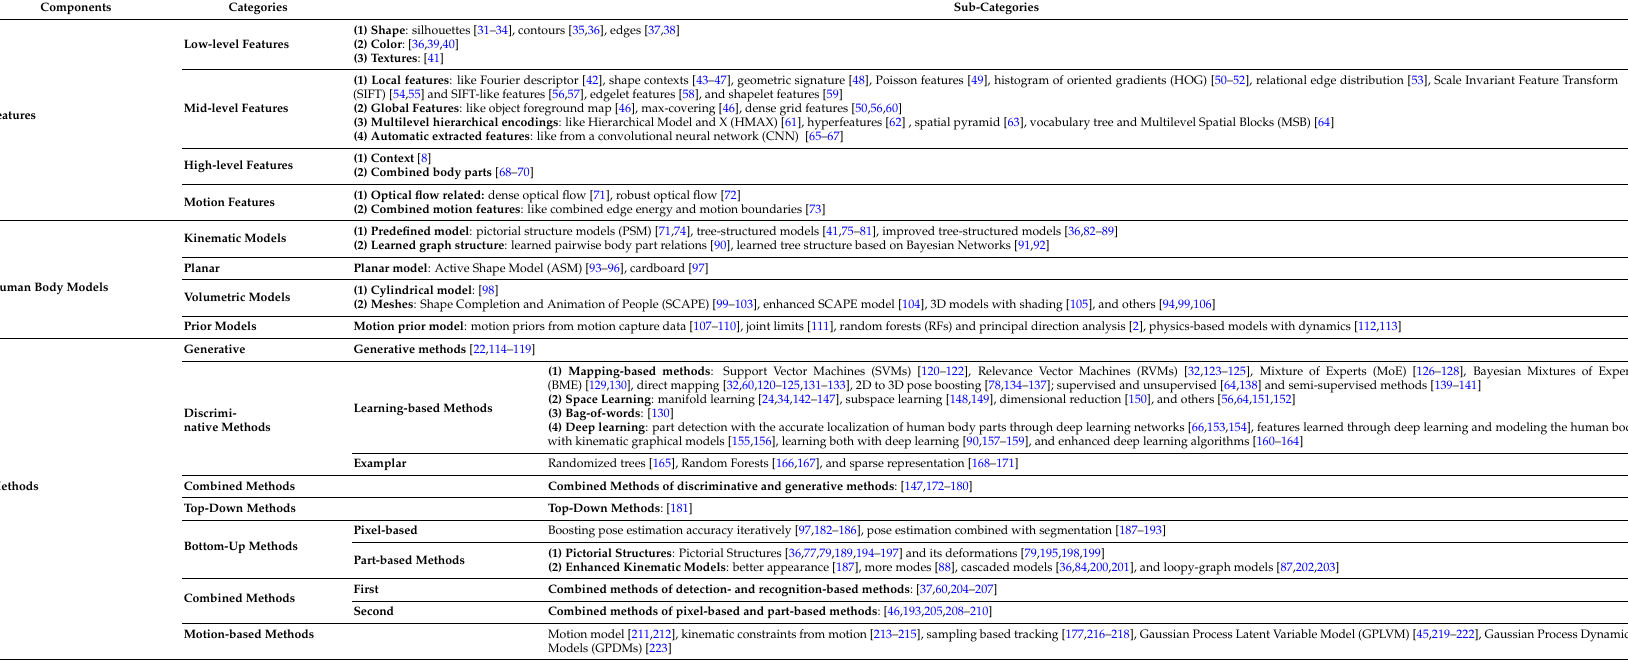
Table 1. A complete overview of human pose estimation from monocular